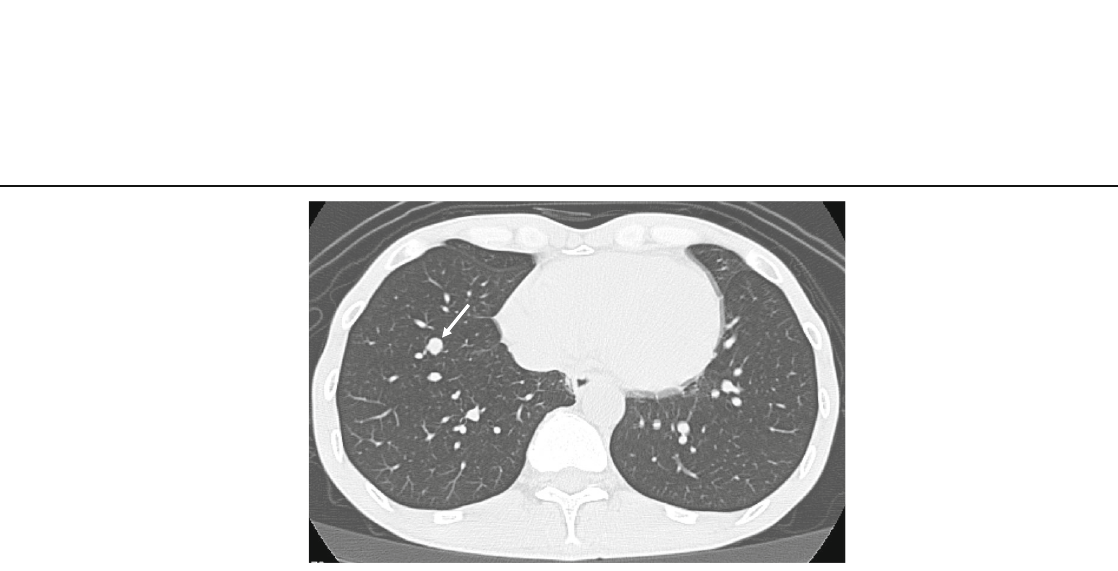
Fig. 4 Computed tomography showed an enlarged nodule in the right lower lung lobe (arrow)